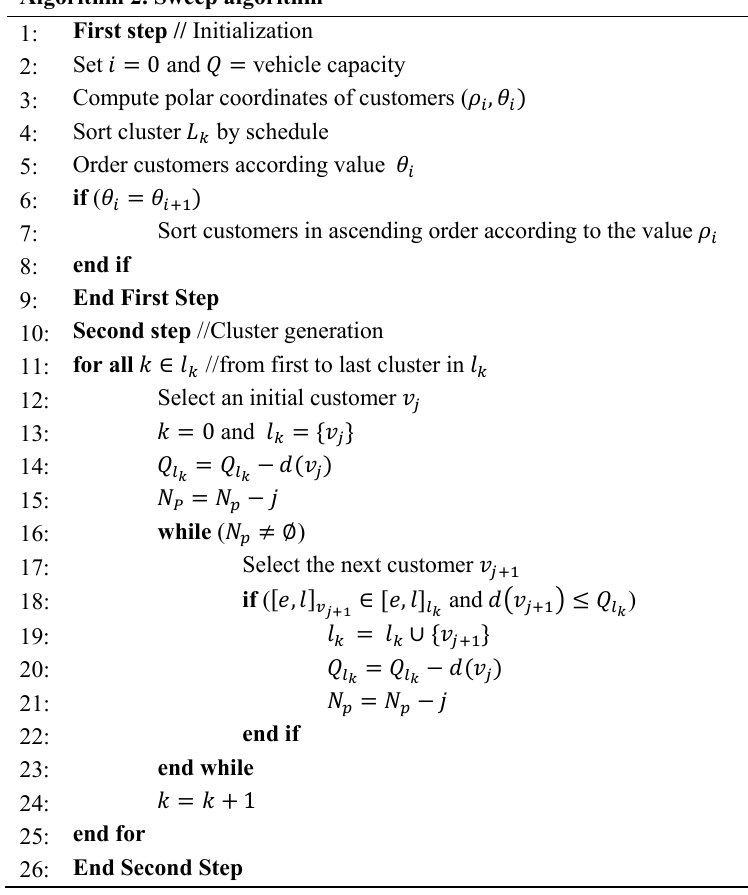
Algorithm 2. Sweep